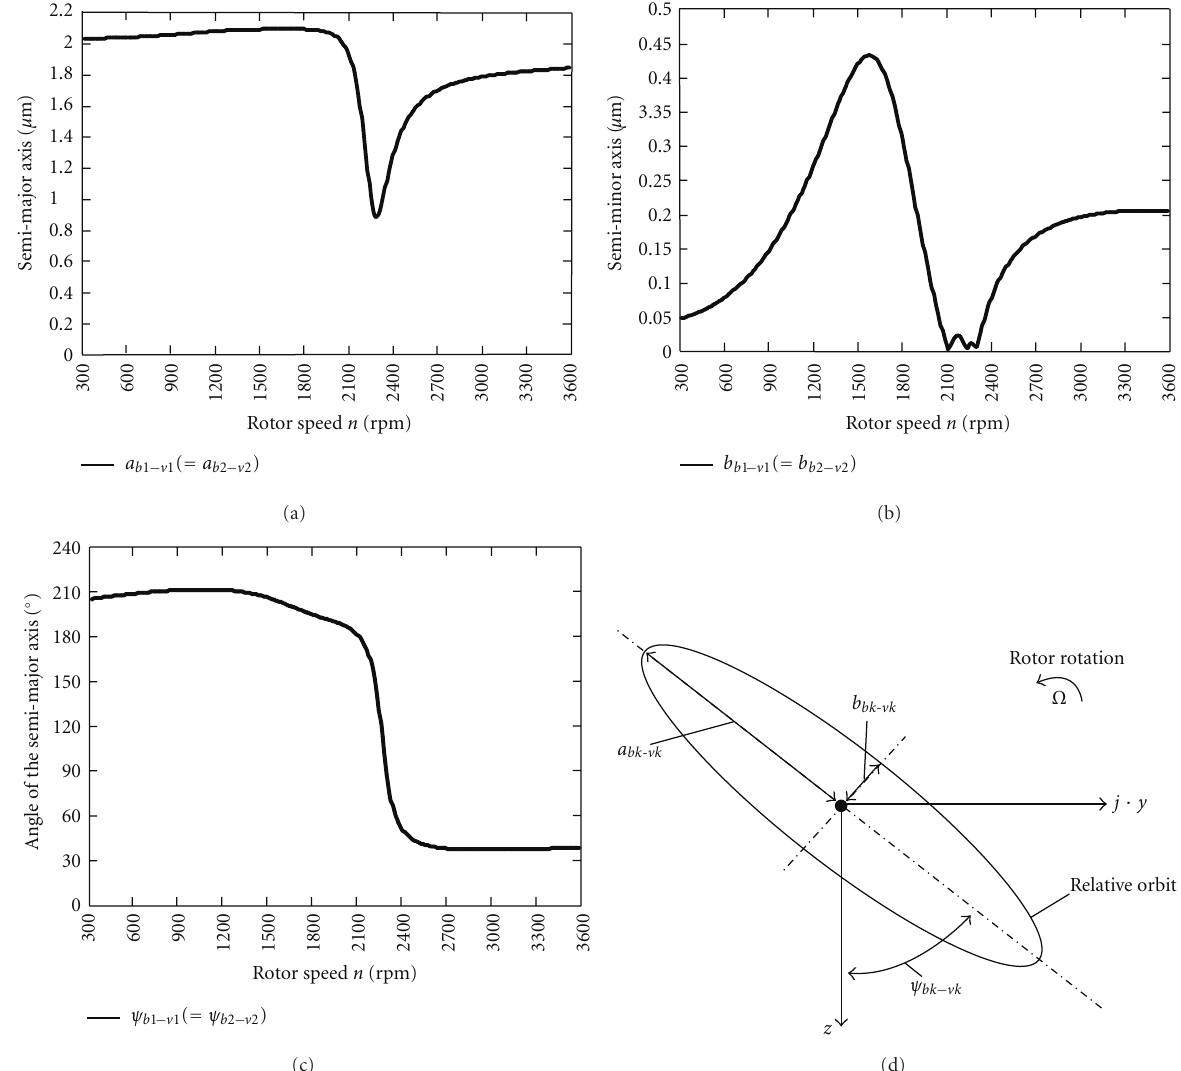
Figure 12: Relative orbits between the bearing housing point B 1 and the shaft journal point V 1 and between B 2 and V 2 , described by (a) the semi-major axes, (b) the semi-minor axes, and (c) the angle of the semi-major axes. (d) Definition of the relative orbits. Boundary condition: identical orientation of the elliptical shaft journals ( ϕ 1 = ϕ 2 ) and di ff erent rotor speeds n .